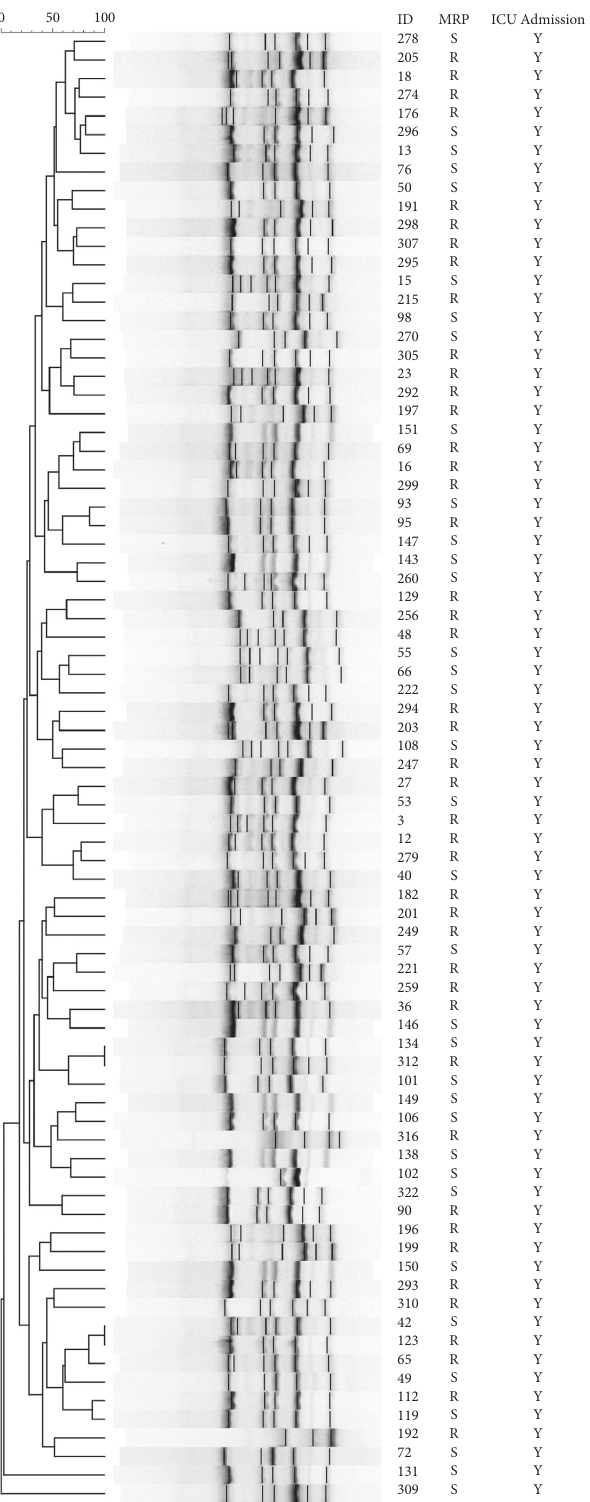
Figure 1: Dendrogram showing genetic diversity of 80 carbape- nem-resistant Acinetobacter baumannii isolated from patients admitted to intensive care units between 2016 and 2018 typed by enterobacterial repetitive intergenic consensus-polymerase chain reaction with the numbers indicating the corresponding strains followed by meropenem susceptibility